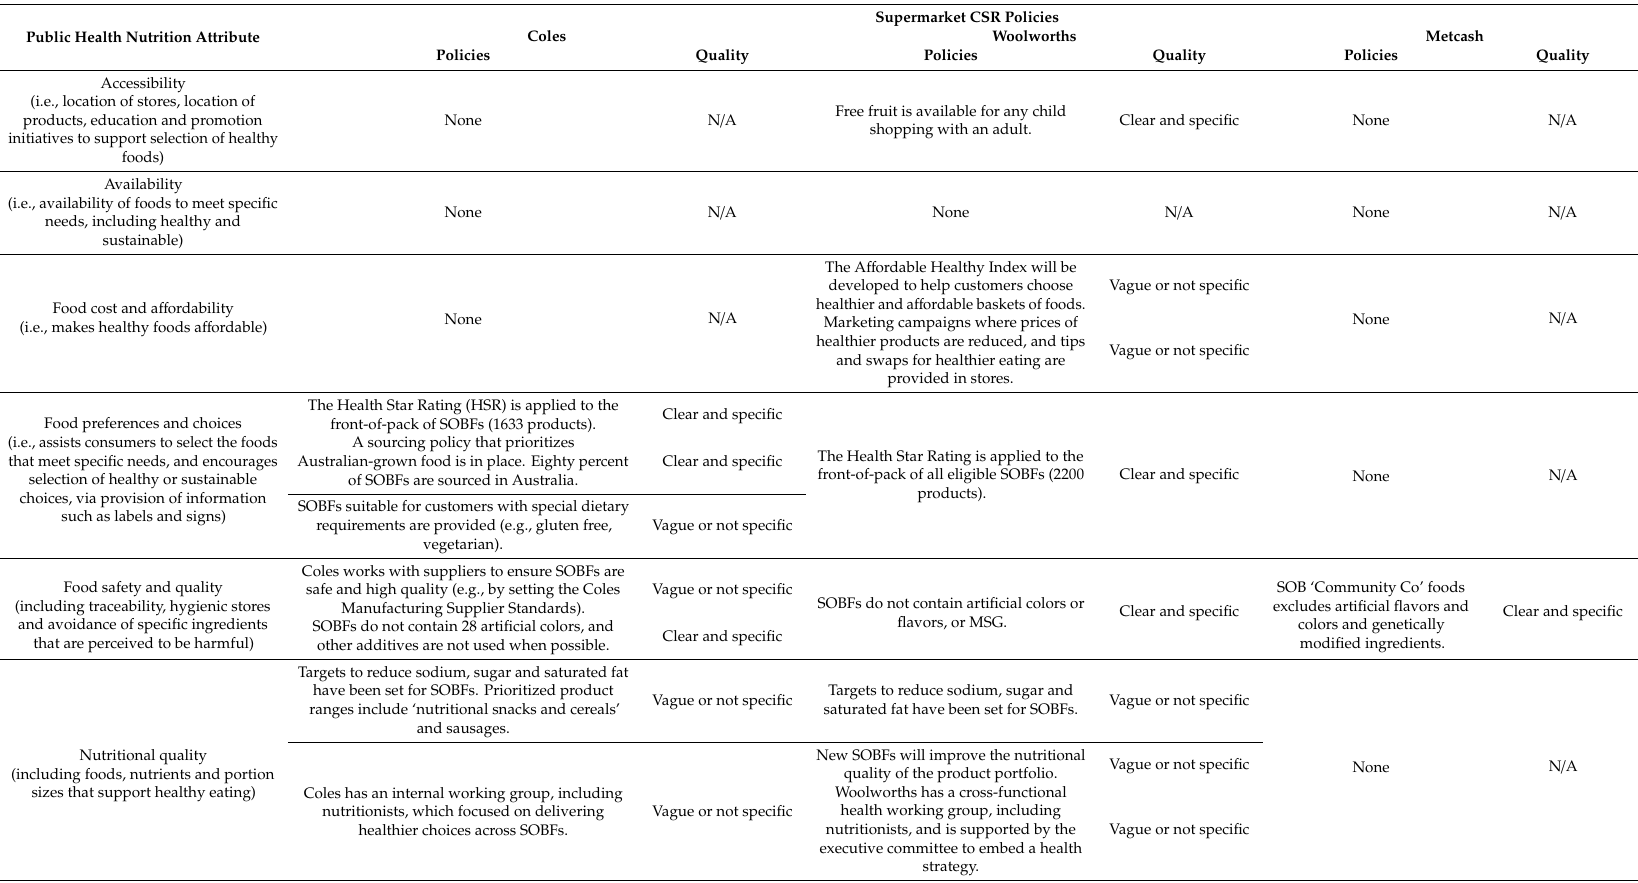
Table 1. Summary of Australian supermarket CSR policies to improve public health nutrition #